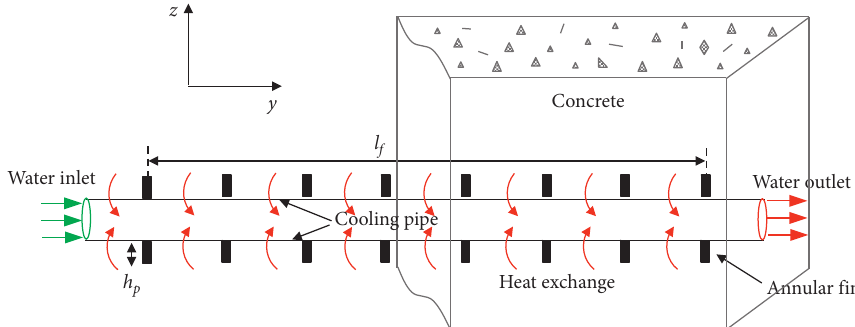
Figure 5: Schematics of massive concrete with the annular finned pipe in yz